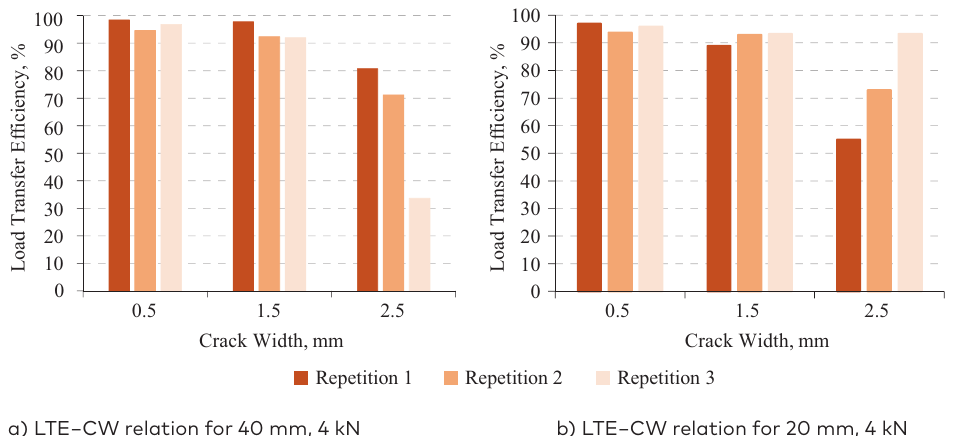
Figure 3. Load Transfer Efficiency behaviour with Crack Width for aggregates 40 mm and 20